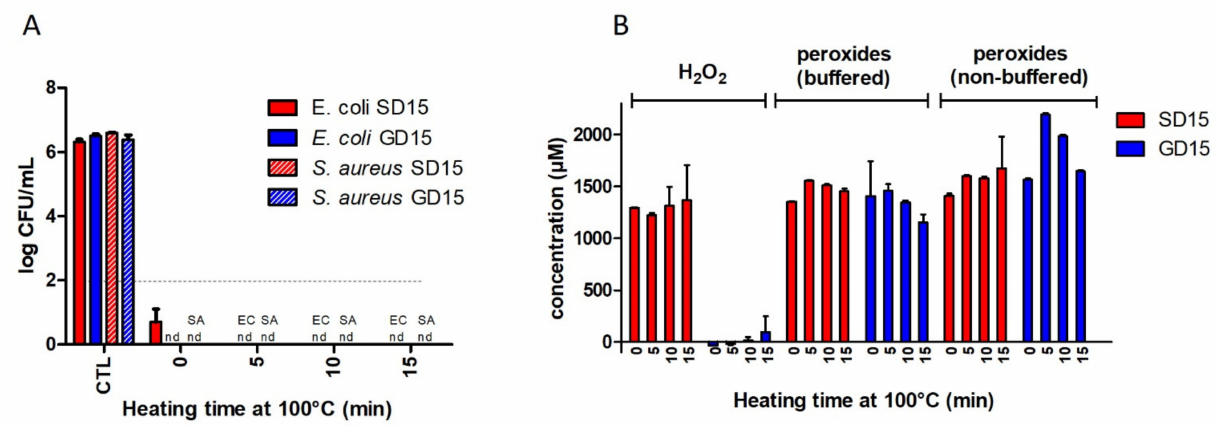
Figure 5. Effect of heating at 100 ◦ C and heating time duration on retention of antimicrobial efficacy of PAW (SD15, GD15). ( A ) Bactericidal effects after 60 min contact time. ( B ) Chemical composition of hydrogen peroxide measured by TiOSO 4 , peroxides measured by buffered KI and nonbuffered KI. Data shown as mean ± SD; nd = no colonies detected. Limit of detection: 2 log 10 CFU/mL. Controls (CTL) consisted of bacterial suspension exposed to untreated deionised water under the same